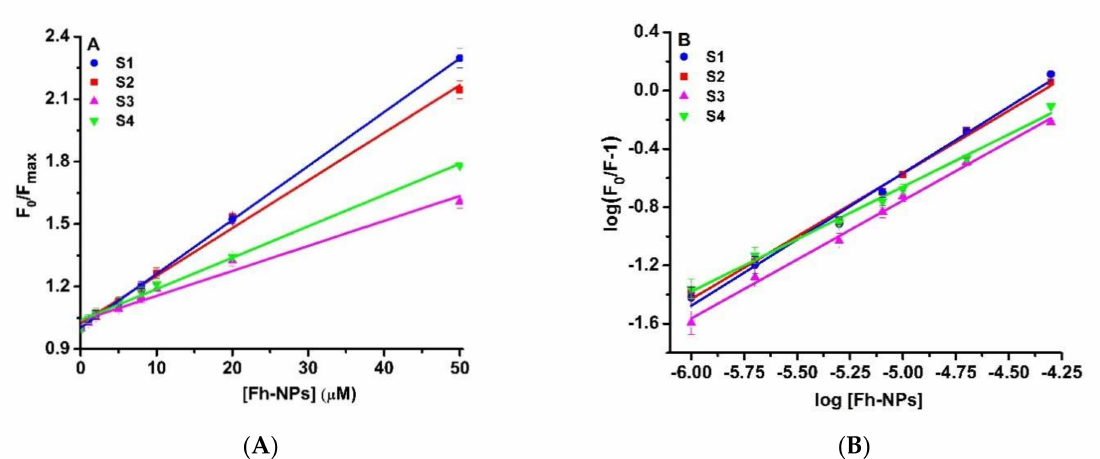
Figure 5. ( A ) The Stern-Volmer representation and ( B ) the Scatchard double logarithmic plot for the